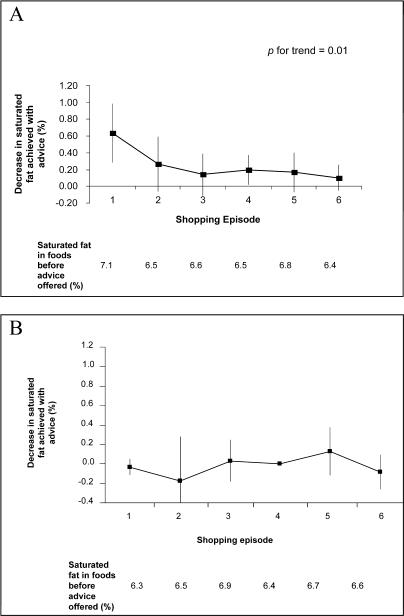
Effects of Repeated Advice in the Intervention (n = 115) and Control Group (n = 121)Squares are placed at the point estimate of the effect observed in the intervention (A) and control (B) groups, and the vertical lines extend to the 95% confidence intervals around the estimate. The p-value for trend in the intervention group indicates a progressive decrease in effect size with repeated shopping episodes. There was no significant decrease in saturated fat at any time point in the control group, nor any trend over time (all p > 0.09).